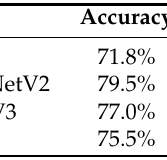
Table 2. Final results related to the considered